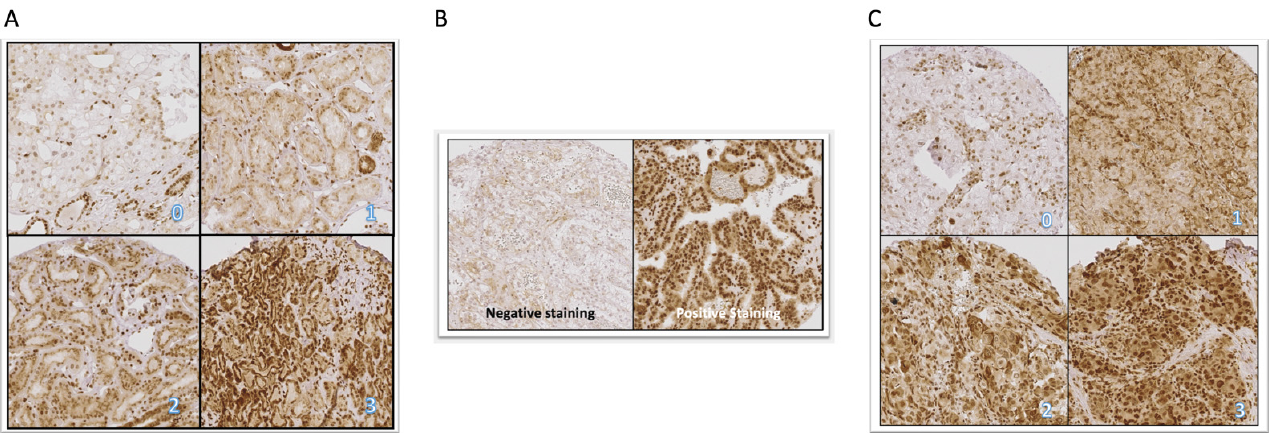
Figure 6. Exemplary illustration of the staining intensities. ( A ) Staining intensities 0–3 in cytoplasmic staining for CXCR4 in malignant samples. Immunoreactivity score (IRS) was obtained by multiplication of the intensity with the percentage (0–100%) of the stained cells, resulting in scores in the range of 0 – 300. ( B ) Illustration of negative and positive nuclear staining for CXCR4 in malignant samples. ( C ) Staining intensities 0–3 in cytoplasmic staining for CXCR4 in benign kidney tissue. Immunoreactivity score (IRS) was obtained by multiplication of the intensity with the percentage (0 – 100%) of the stained cells, resulting in scores in the range of 0–300.